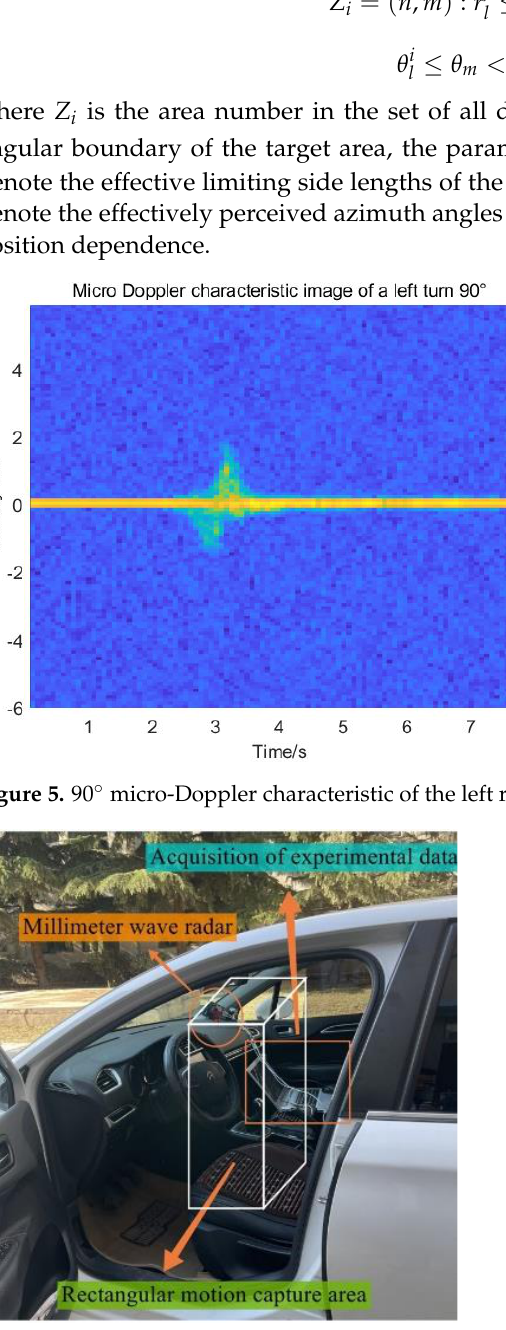
Figure 6. Radar effectively identifies equipment and space.